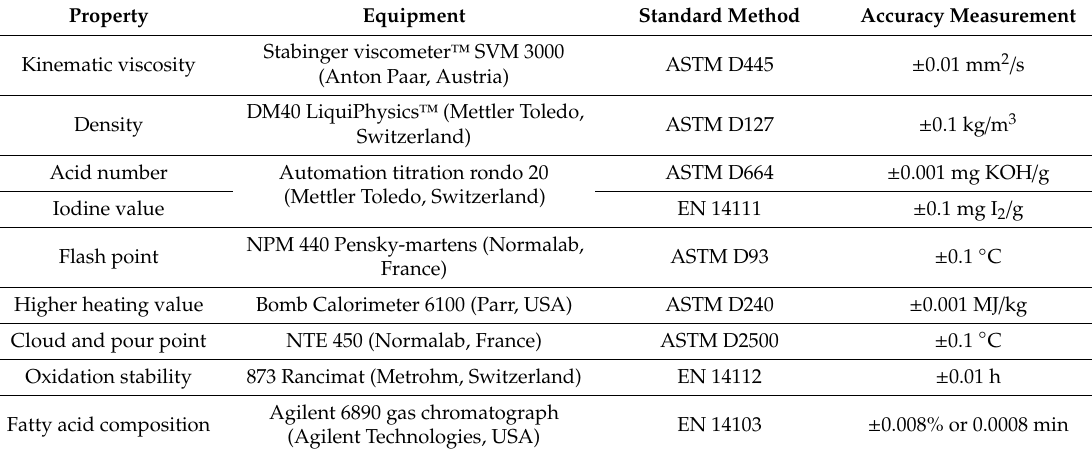
Table 2. The equipment used to determine the properties of C. manghas oil and